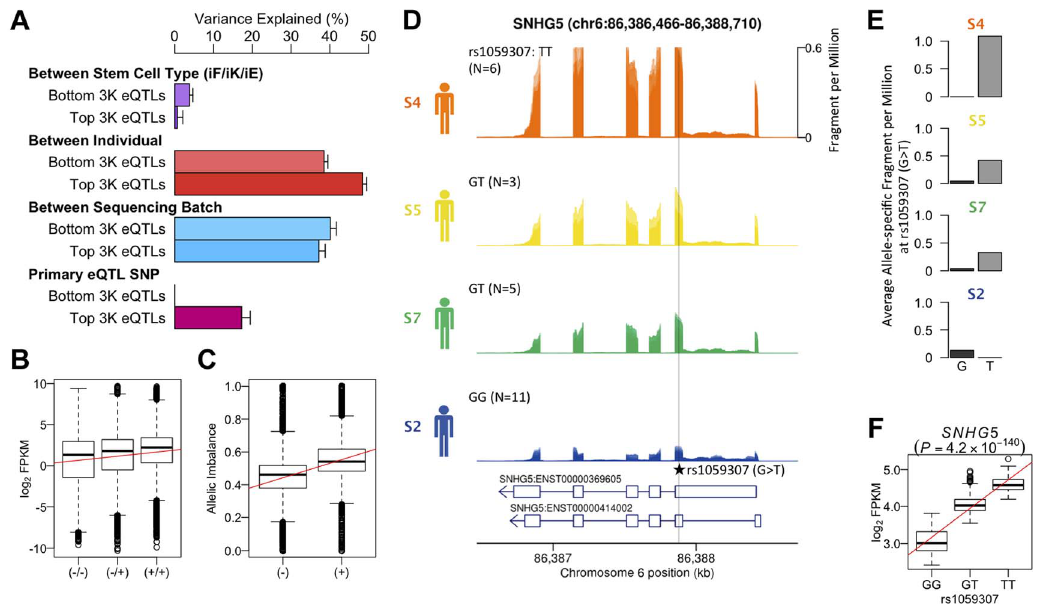
Figure 4. Genetic effects on transcription in iPSCs. (a) Variance component of known eQTL genes showing primary eQTL SNPs being able to explain 17% of FPKM variation on average. Top and bottom 3,000 eQTL genes and SNPs were determined by means of P-values using gEUVADIS RNA-seq data [27]. (b) Box- plot of log2 FPKM aggregated across 462 eQTL genes (FDR 5%) stratified into high ( + / + ), medium ( + / 2 ) and low ( 2 / 2 ) genotypes at the minimum p-value eQTL SNPs ascertained from [2] (FDR 5%). Pearson correlation r=0.44, p , 9.8 6 10 2 68 . (c) Boxplot of allelic imbalance at high-expression ( + ) and low-expression ( 2 ) haplotypes across all eQTL genes ascertained from [2]. The red line is at 0.5 indicating the expected fraction under the null. Student t p , 1.3 6 10 2 8 . (d) Mean RNA-Seq coverage depth in iPSCs, averaged across all iPSC lines from each individual, at a putative example eQTL for the noncoding RNA SNHG5 gene. Individuals are grouped by their genotype at the putatively causal variant rs1059307. Individual genotypes are shown with the number of RNA-seq samples in parentheses. (e) Average coverage depth of fragments coming from the high-expression haplotype (allele T) and low- expression haplotype (allele G) at rs1059307. (f) eQTL association of SNHG5 gene at rs1059307 in lymphoblastoid cell lines from [2] showing distributions of log2 FPKM against SNP genotypes at rs1059307. The red line shows the best- fit linear regression line.